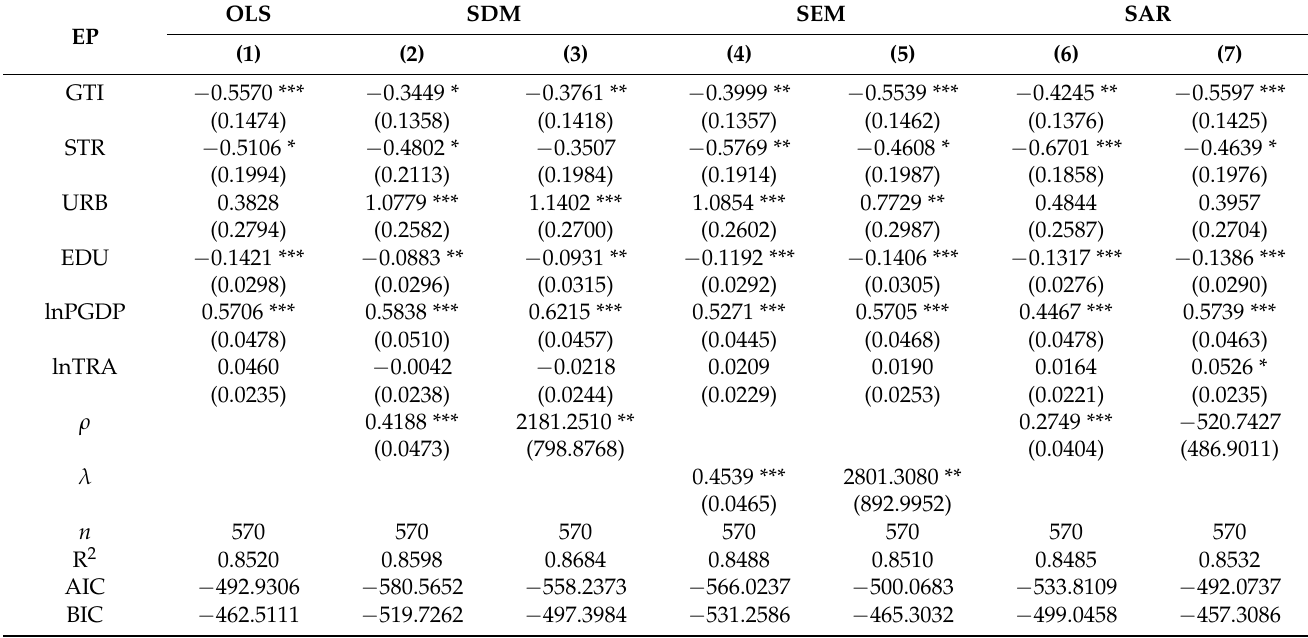
Table 5. Spatial panel regression results of GTI on